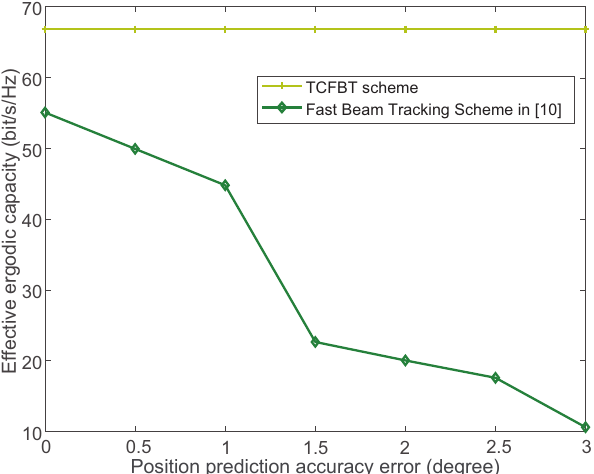
Figure 10. The effective ergodic capacity vs. position prediction accuracy error.